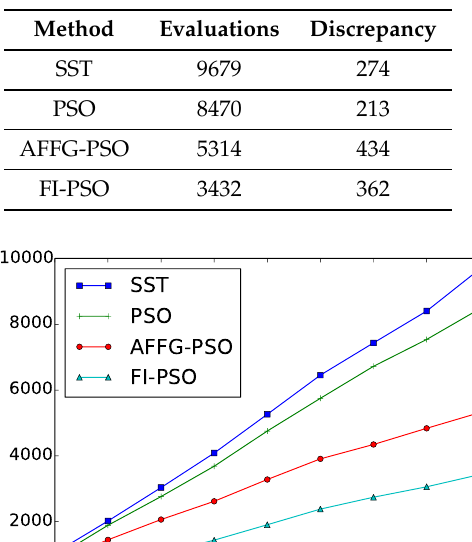
Table 1. “Wax” Evolutionary Approximation results.